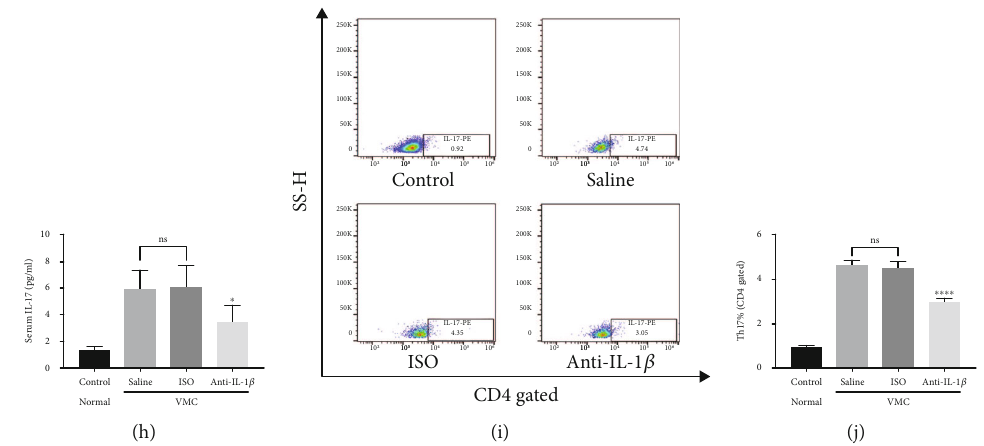
Figure 6: Blockade of IL-1 β can signi fi cantly alleviate the severity of VMC in Balb/c. (a) Statistical analysis of survival rate from day zero to day sixteen in control, anti-IL-1 β , saline, and ISO groups. (b) HE images of myocardial in control, anti-IL-1 β , saline, and ISO groups at sixteenth day of CVB3-induced VMC process (original magni fi cation × 100). (c) Masson-trichrome staining of myocardial in control, saline, ISO, and anti-IL-1 β groups at sixteenth day of CVB3-induced VMC process (original magni fi cation × 100). (d) IHC images of IL- 17 in myocardial in control, saline, ISO, and anti-IL-1 β groups at sixteenth day of CVB3-induced VMC process (original magni fi cation × 100). (e) IL-17 expression in heart tissue acquired by IHC assay and IOD value was calculated by Image-Pro Plus. (f, g) The relative mRNA expression of ROR γ t and IL-17 in myocardium in control, anti-IL-1 β , saline, and ISO groups at sixteenth day of CVB3-induced VMC process. (h) The protein level of IL-17 in plasma in control, anti-IL-1 β , saline, and ISO groups at sixteenth day of CVB3-induced VMC process. (i) The proportion of Th17 cells in spleen samples in control, anti-IL-1 β , saline, and ISO groups at sixteenth day of CVB3- induced VMC process. (j) Statistical histogram of Th17 proportion in (i). Statistical description: ns, ∗ , ∗∗ , and ∗∗∗∗ stand for no statistically signi fi cant di ff erence, P < 0 : 05 , P < 0 : 01 , and P < 0 : 0001 , respectively, for anti-IL-1 β group versus saline or ISO